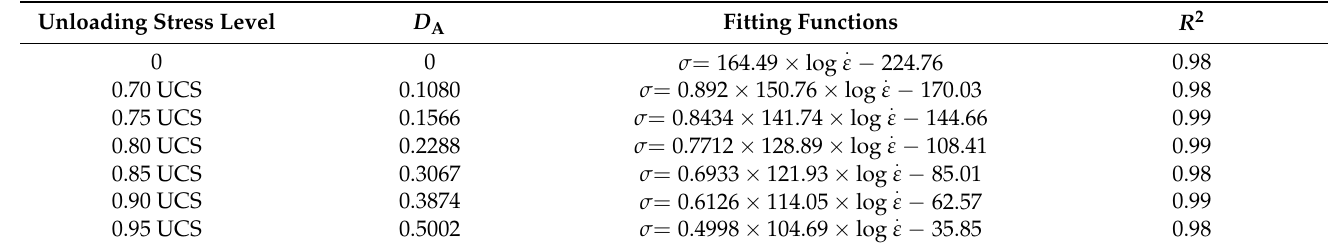
Table 3. Fitting functions between the uniaxial compressive strength and strain